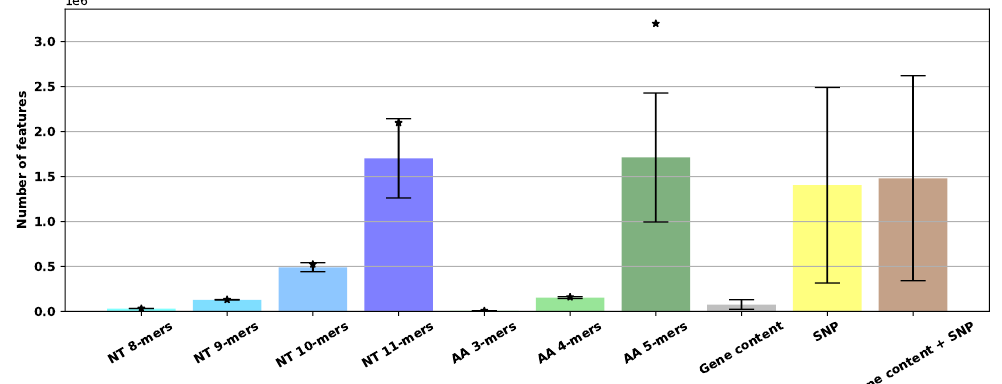
Figure 3. Average and standard deviation of number of features for each method across all species. An asterisk indicates the maximum theoretically possible number of k -mer features, where